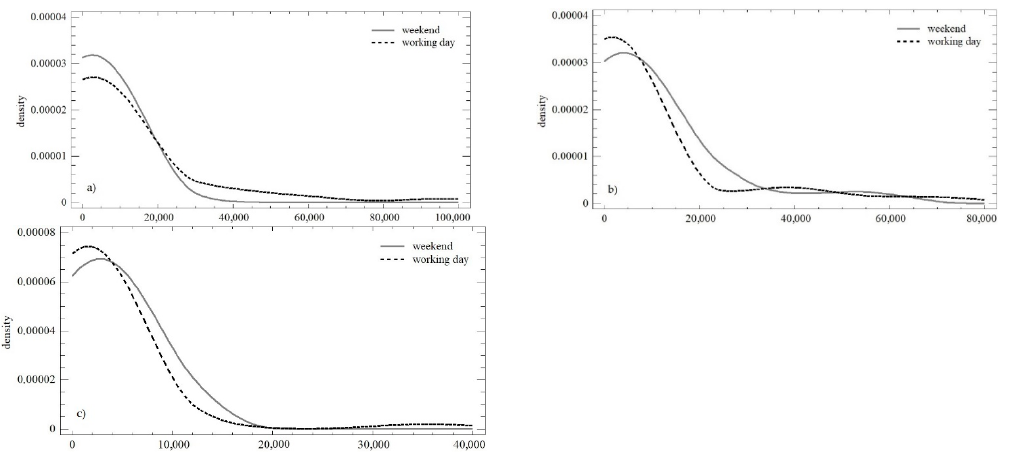
Figure 5. Density plot of number of comments over the three monitored observation periods: ( a ) observation no. 1; ( b ) observation no. 2; ( c ) observation no.